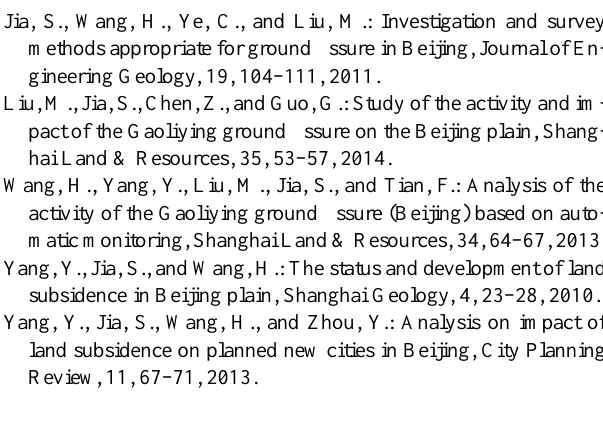
mation gradient of the ground surface is relatively large along the two cross-sections, with maximum differences of nearly 28 and 25 mm year − 1 ,